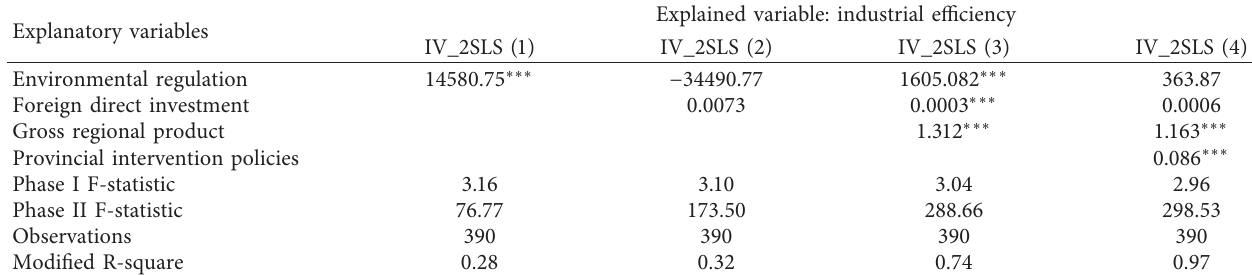
Table 6: Estimation results of instrumental variables